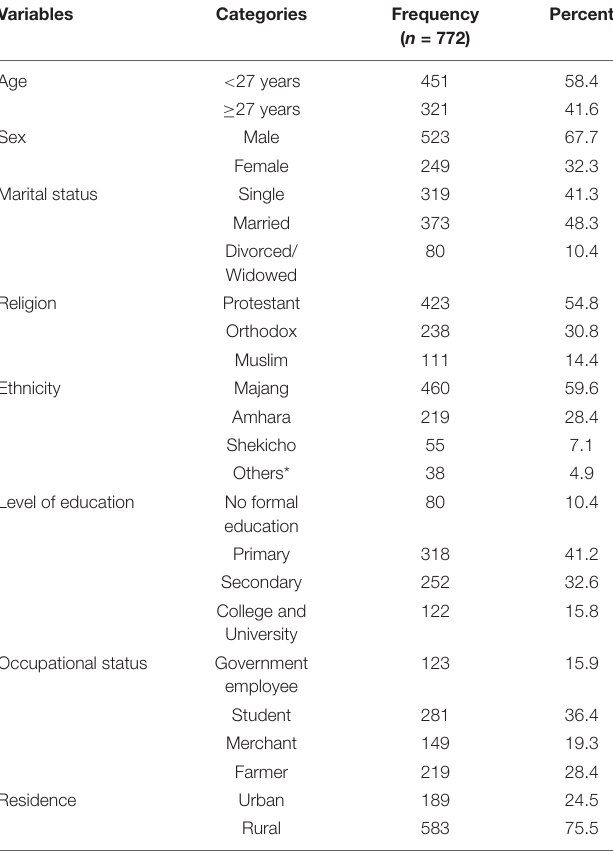
TABLE 1 | Socio-demographic characteristics of the respondents at Majang zone in Southwest Ethiopia, 2019.